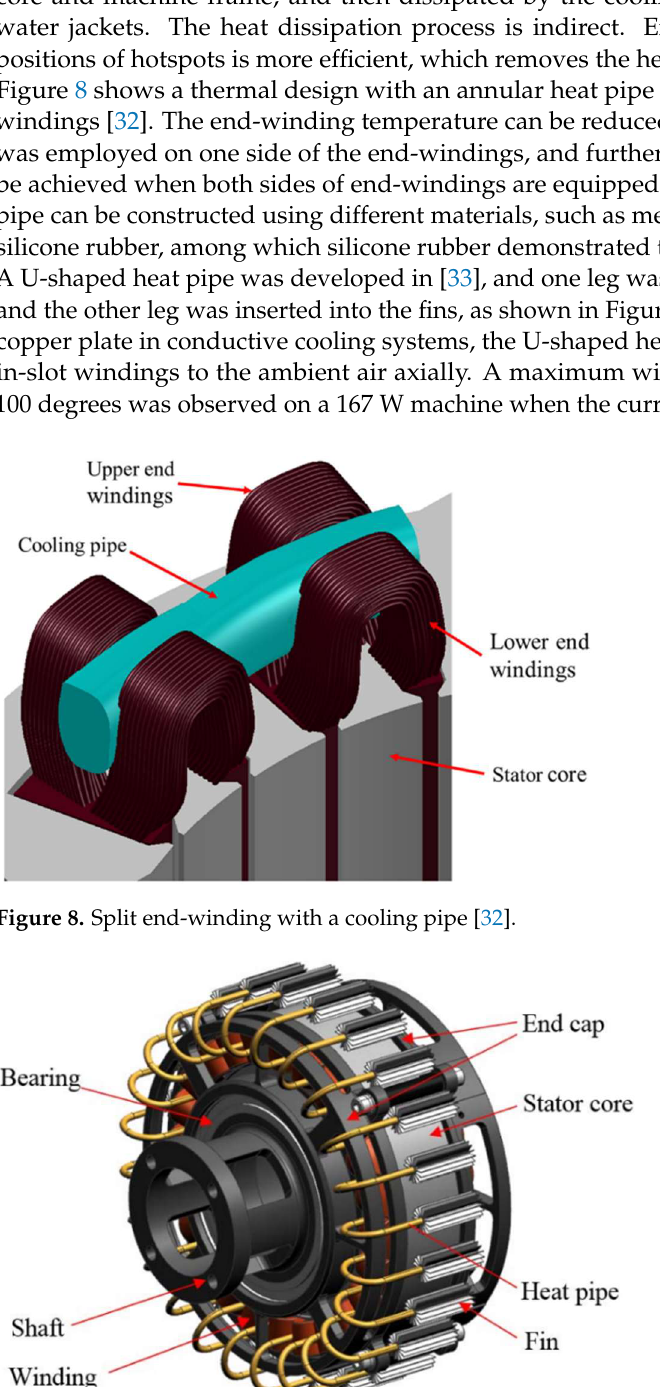
Figure 7. Cross section of a machine stator with extended end-winding insert [31].